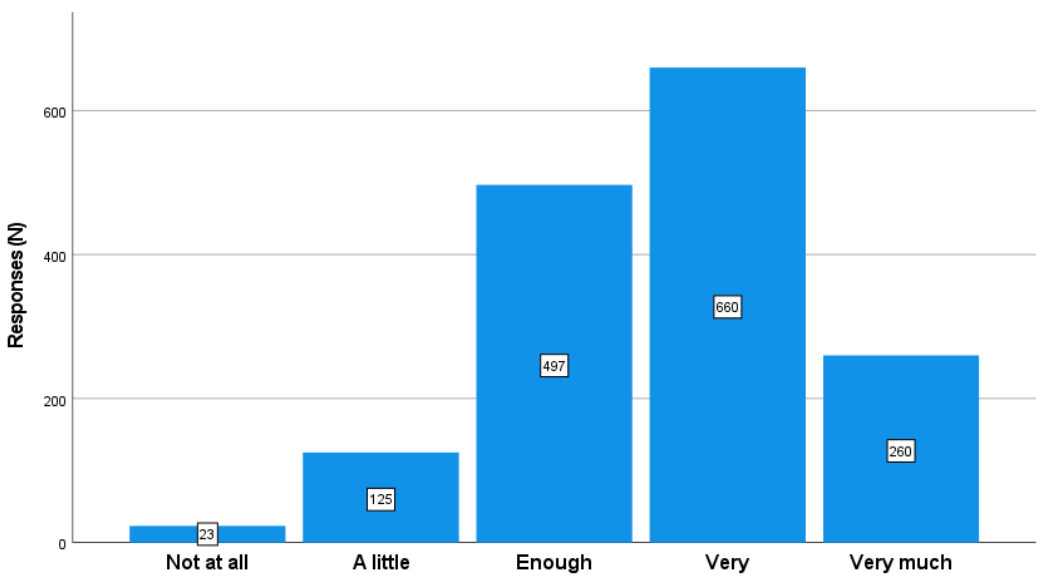
Figure 1. Responses to the question, “How informed do you think you are about environment protection and recycling?”